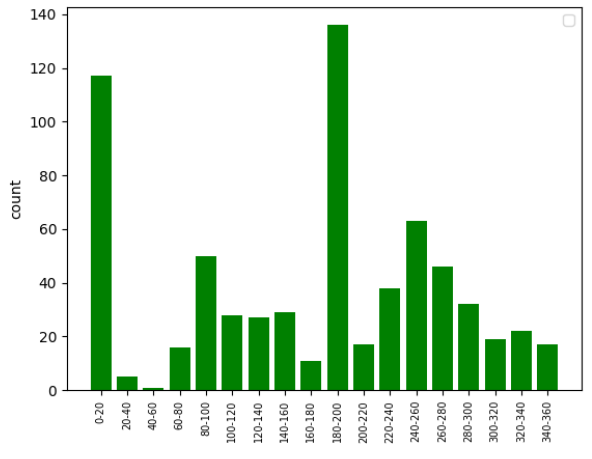
Figure 4. Orientation distribution for SSS dataset distributed into 18 bins with a bin size